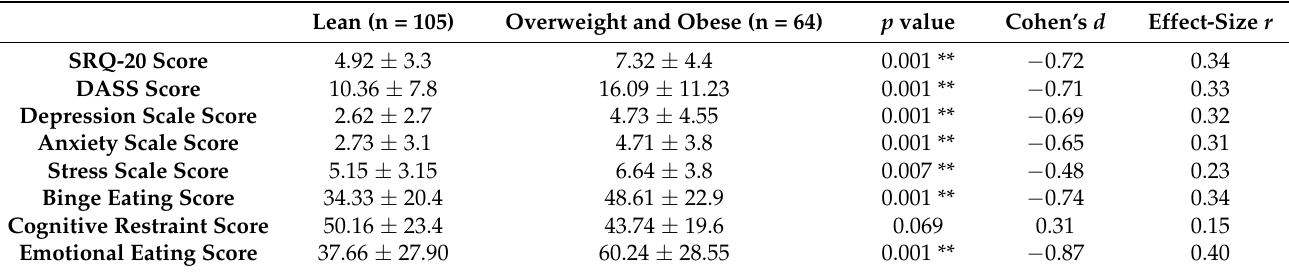
Table 2. Mental health and eating behavior scores.